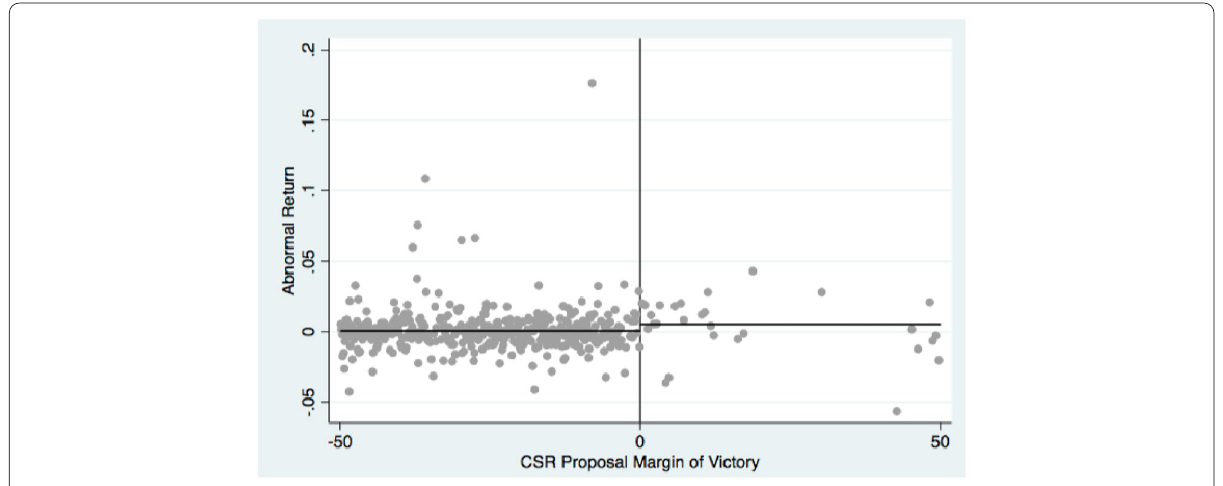
Fig. 2 Abnormal returns on the day of the